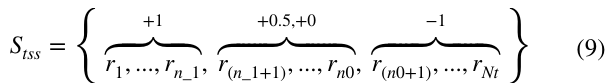
Fig. 2 Illustration of grid features in the random variable space with two random